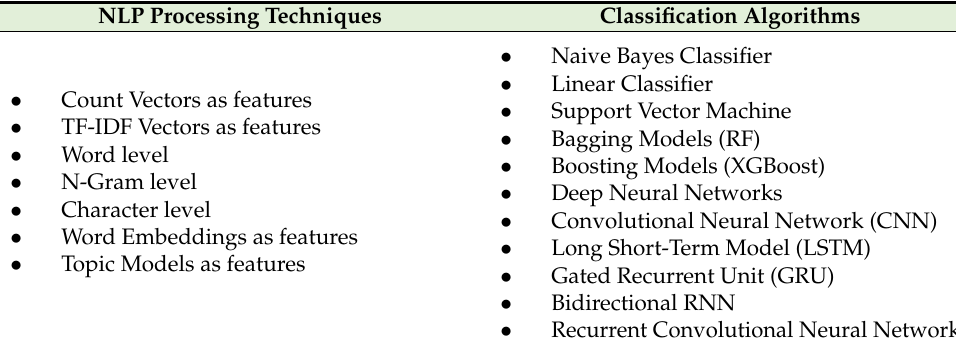
Table 1. NLP processing and base model